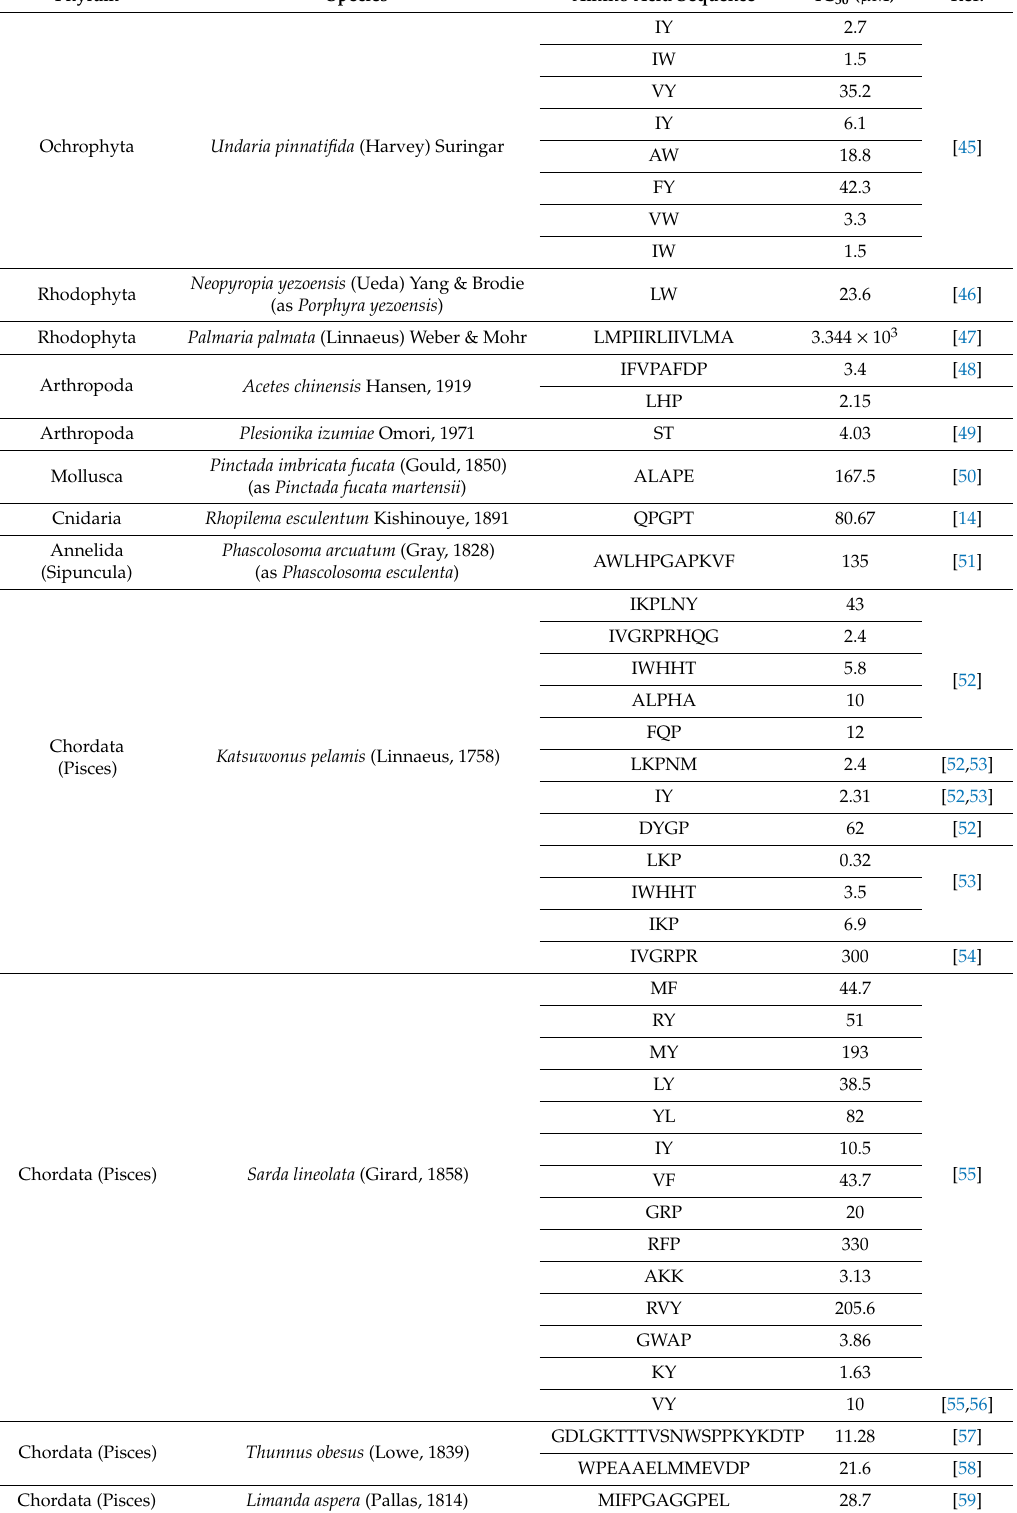
Table 1. Cardiovascular active peptides from aquatic organisms / ACE Inhibitory peptides* modified from